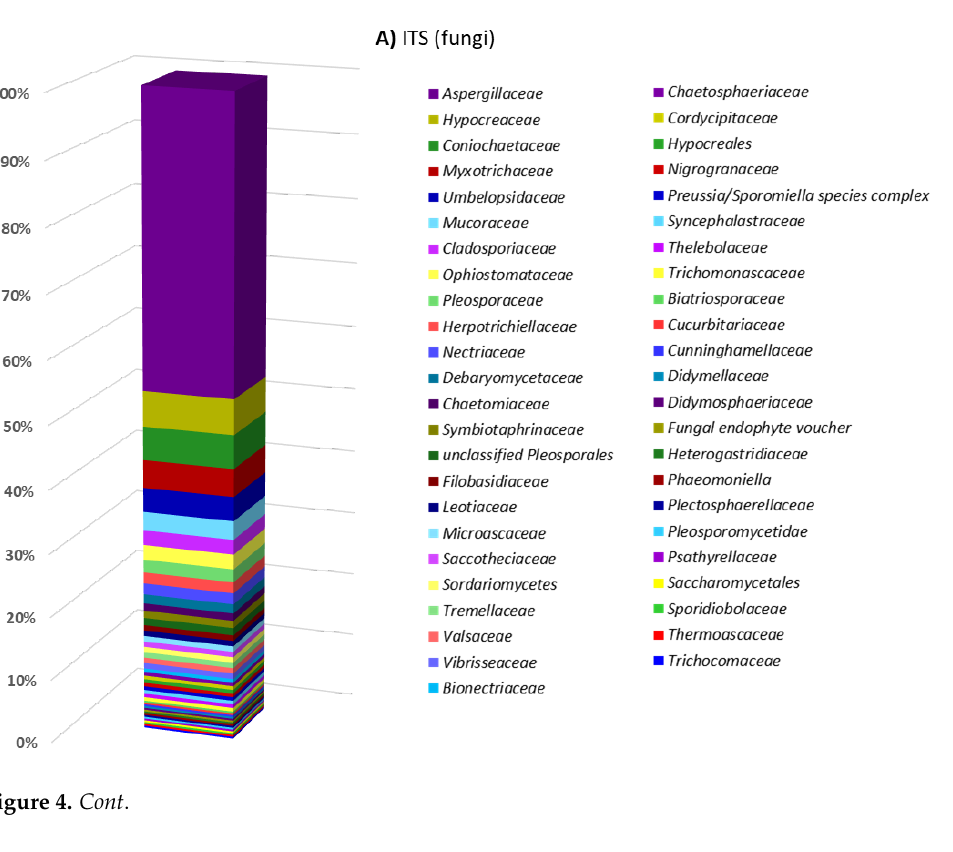
Figure 4. Abundance of microorganisms isolated from wood-decay samples at family level. Each panel presents the family names ordered according to the number of strains isolated from each fam- ily: ( A ) fungal families; ( B ) bacterial families.